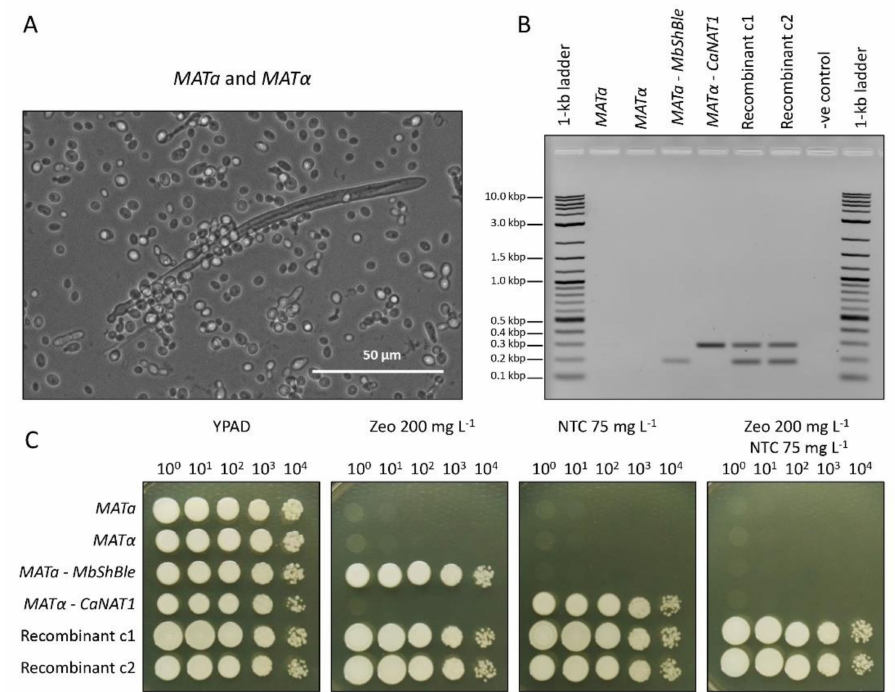
Figure 3. Mating experiments with marker-transformed M. borealis . ( A ) Photograph of a large mating ascospore. MbShBle -transformed MATa and CaNAT1 -transformed MAT α were mated for two days on 1 ⁄ 2 -strength glucose broth lacking histidine and uracil (Teknova), collected in YPAD, and photographed under a light microscope. ( B ) Genotyping results of marker-transformed diploids. Recombinant colonies harbouring both selectable markers were purified by spot dilution on YPAD with 200 mg L − 1 zeocin and 75 mg L − 1 nourseothricin. Recombinant colonies were genotyped by Qiagen multiplex with primers that amplify the CaNAT1 and MbShBle genes, alongside marker-transformed haploid strains and untransformed controls. MbShBle product size ( C ) Spot-dilutions of mated-colonies alongside transformed haploid strains and untransformed controls on YPAD, YPAD with 200 mg L − 1 zeocin, YPAD with 75 mg L -1 nourseothricin, and YPAD with 200 mg L − 1 zeocin and 75 mg L − 1 nourseothricin. Plates were incubated at 30 ◦ C for two days. NTC = nourseothricin; Zeo = zeocin; G418 =